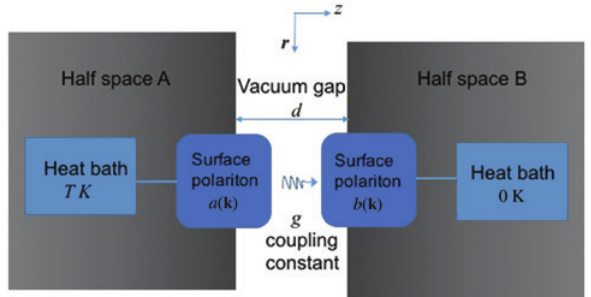
Figure 1: Coupling between two surface modes, each connected to its own heat bath that is analyzed in this